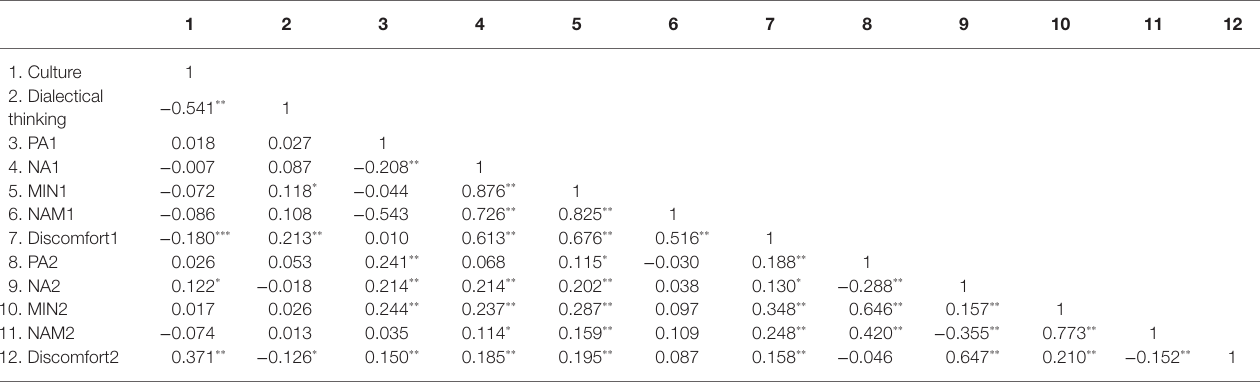
TABLE 2 | Correlations between dialectical thinking and emotional experience induced by conflict stimuli ( N = 318).